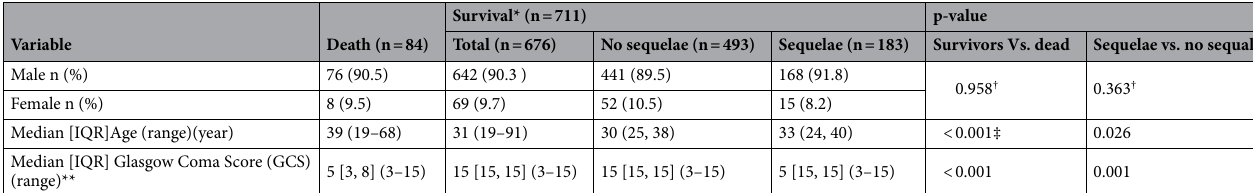
Table 1. Methanol-poisoned patients’ data during the COVID-19 pandemic in Iran (n = 795). IQR Interquartile range, GCS Glasgow Coma Scale. *Missing data in some cases for defining the sequelae, as they left hospital against medical advise or transferred to another hospital. † Applying Person’s Chi-square. ‡ Applying Man-Whiteny U test. **GCS could not be measured due to ongoing resucitation on admission is some